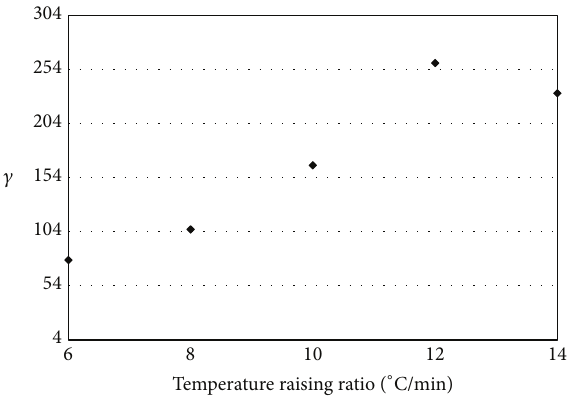
Figure 7: Activity coefficient of produced char at different temper- ature raising ratios.